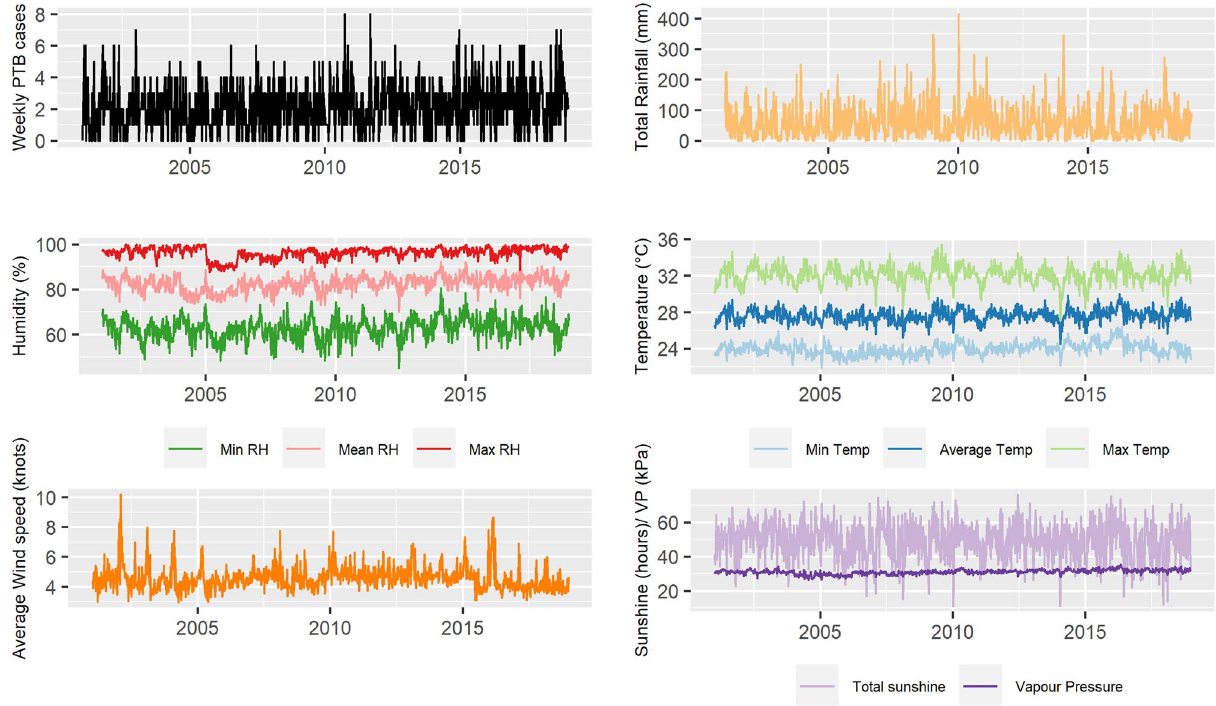
Figure 1. Time series for weekly PTB case counts and climate variables from January 2001 to December 2018 at Brunei-Muara district,